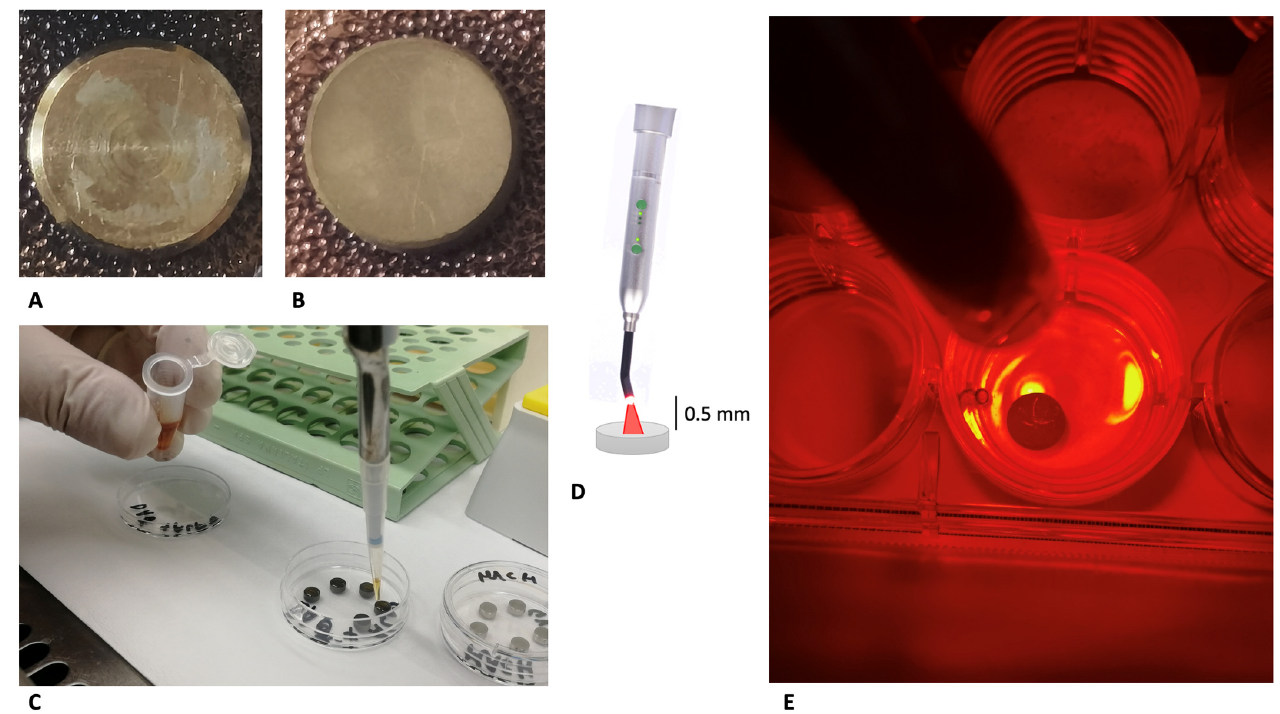
Figure 1. Study design: machined ( A ) and DAE ( B ) discs before experimentation. Application of ALAD ( C ) to the discs following pretreatment with human saliva and incubation for 24 h with Streptococcus oralis . Irradiation of the discs for 7 min with a 630 nm LED, illustration ( D ), and photograph ( E ).